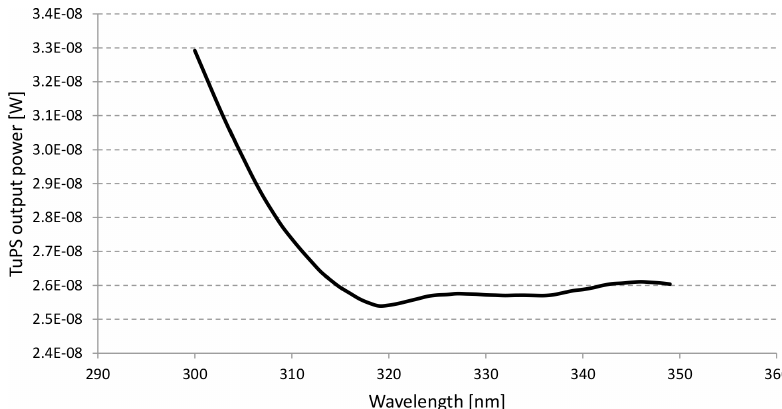
Figure 7. Optical power output of TuPS light engine in the spectral region of